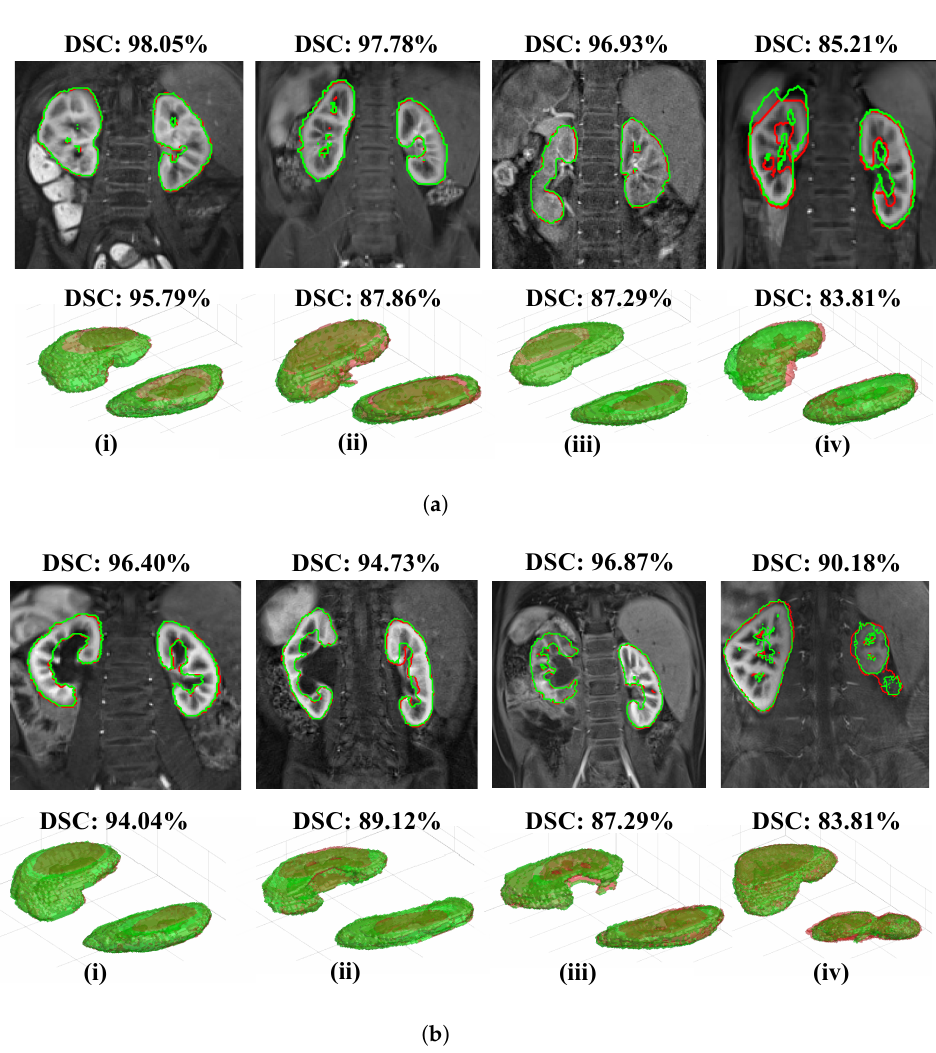
Figure 3. Whole-kidney segmentation results in eight different DCE-MRI scans (4D volumes). Every column corresponds to one MRI volume. The first row displays a sample DCE-MRI coronal slice with the segmentation outcome (green) overlapping the ground truth (red) and dice similarity coefficient (DSC). The second row displays a 3D reconstruction of the kidney and DSC. ( a ) Segmentations in four clinically “normal” cases; ( b ) Segmentations in four clinically “abnormal”